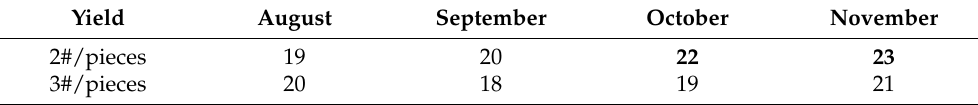
Table 7. Processing yield of machine 2# and machine 3# in August, September, October and November.